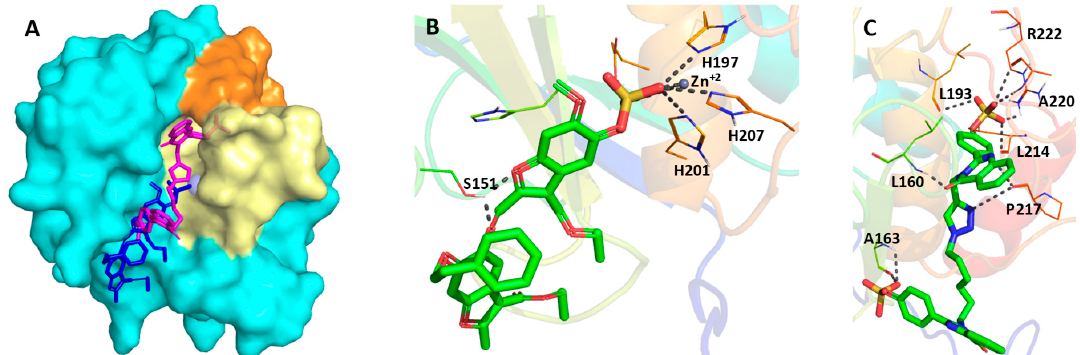
Figure 5. ( A ) Surface representation of MMP-8 (cyan) showing the potential interacting sites of sulfated benzofuran 26 (blue) and sulfated quinazolinone 38 (magenta). The S 1 ’ pocket and specificity loop are shown in pale yellow and orange, respectively. ( B , C ) Polar interactions of NSGM 26 ( B , shown in sticks) and NSGM 38 ( C , shown in sticks) with MMP-8 (cartoon). Interacting residues of MMP-8 are shown as lines, catalytic Zn +2 ion as a sphere, and polar interactions as grey dotted lines.